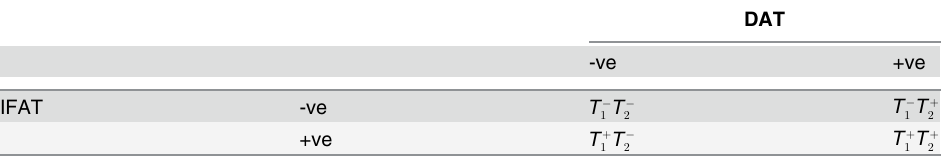
Table 1. Data structure per locality per sampling round. T j 2 = DAT) and j = test result ( – = negative, + =